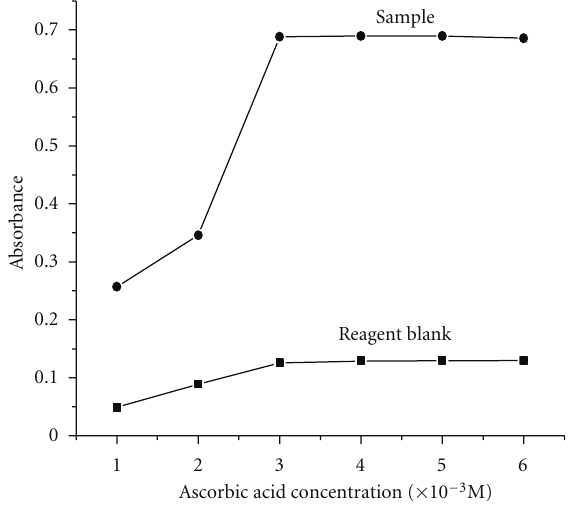
Figure 5: E ff ect of ascorbic acid.